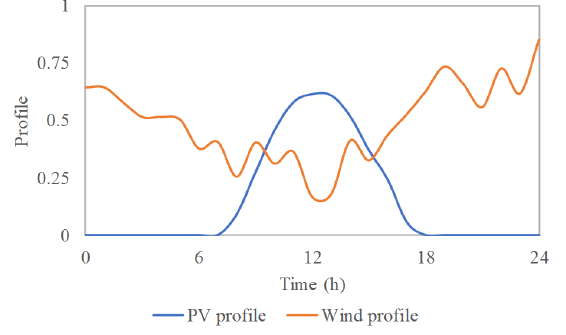
Figure 5. Profiles of solar and wind